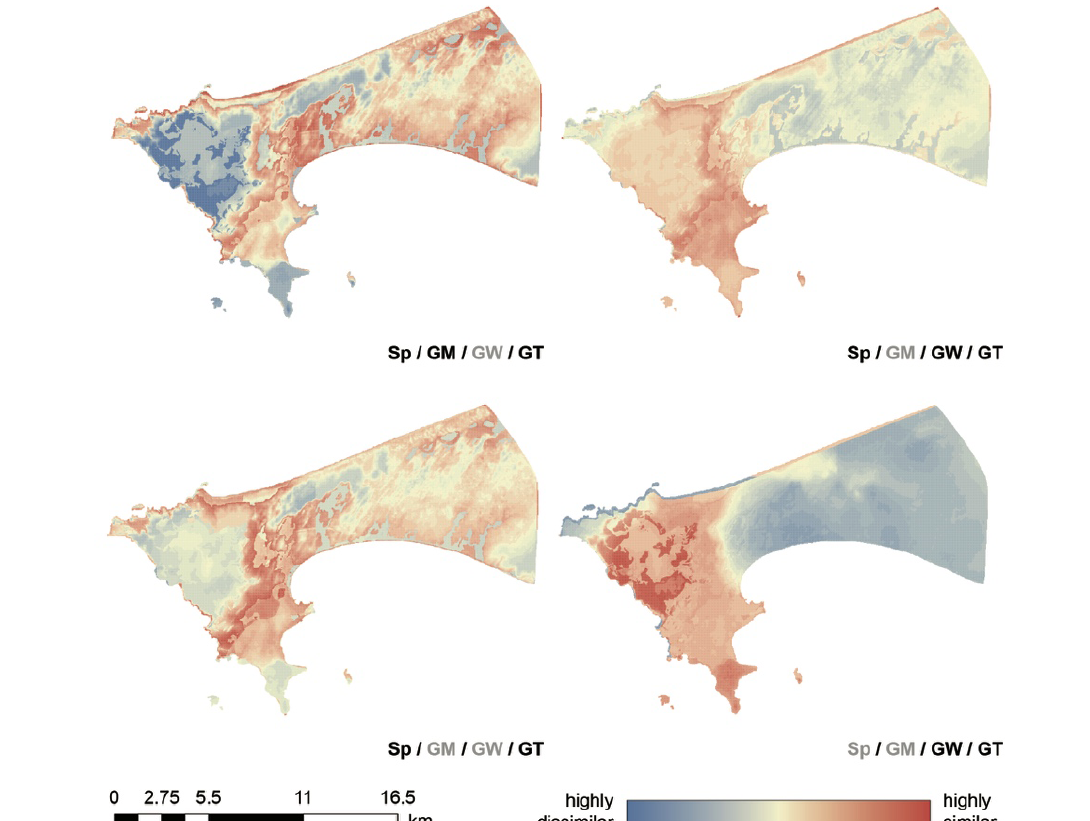
Figure 3. Degree of similarity to different combinations of resource potentials in the city of Dakar (Sp = space; GM = geo- materials; GW = groundwater; GT = geothermal) (Doyle, 2016b, pp.